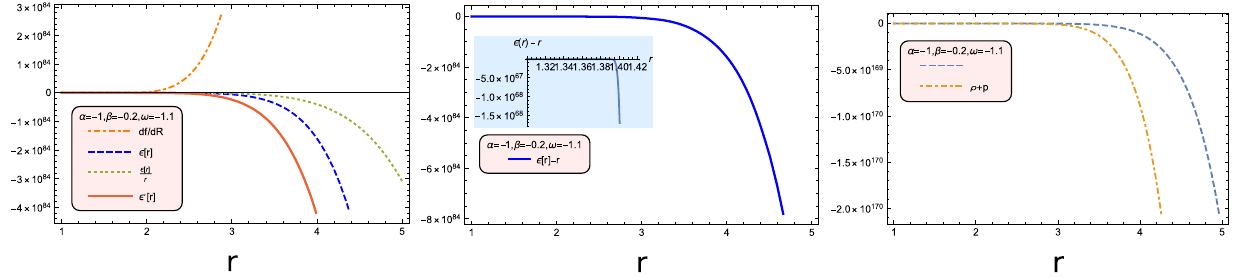
Fig. 8 First plot shows the behaviour of (cid:6) − r (1st), 1 − (cid:6) and (cid:6) (cid:5) by using α = − 1 , β = − 0 . 2 and ω = − 1 . 1 for barotropic pressure. Second r plot verify the violation of non-existence theorem and third plot shows that NEC is respected at the throat but WEC is violated at the